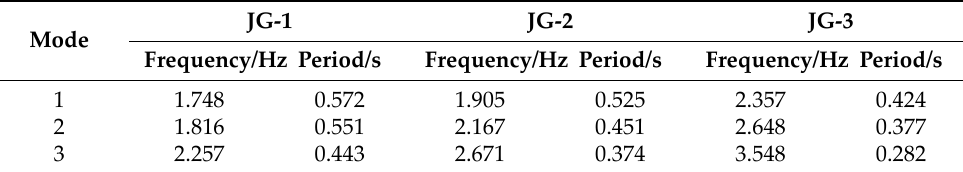
Table 3. Modal analysis of the three structures JG‑1, JG‑2, and JG‑3.